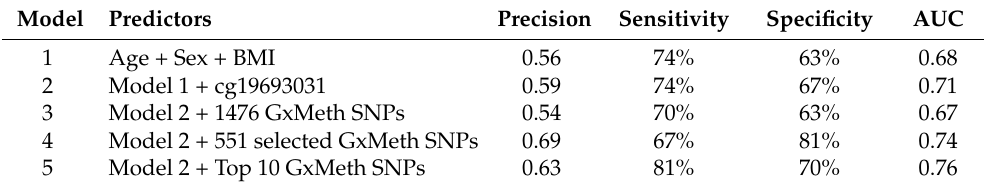
Table 12. Balanced random forest models performance metrics for predicting normoglycemic vs. diabetic subjects.